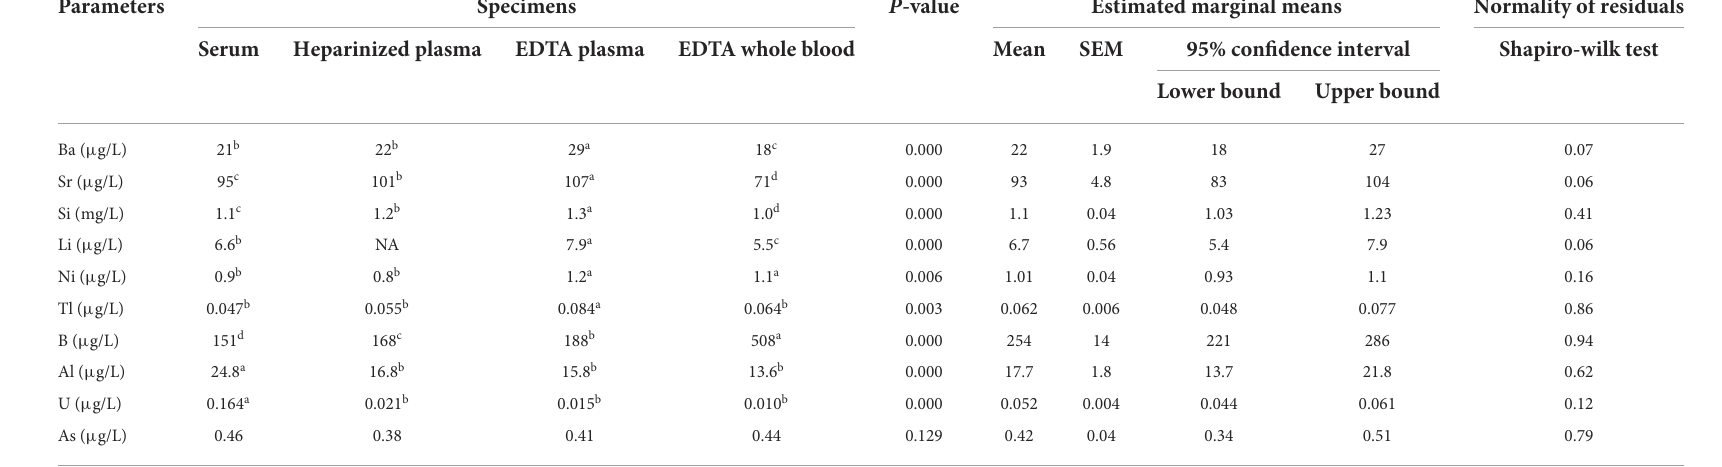
TABLE 6 Linear mixed model analysis of accidental and toxic elements in different blood specimens of dairy cows ( n = 10).